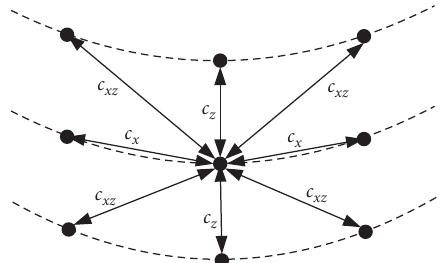
Figure 2: Schematic diagram of mutual coupling of